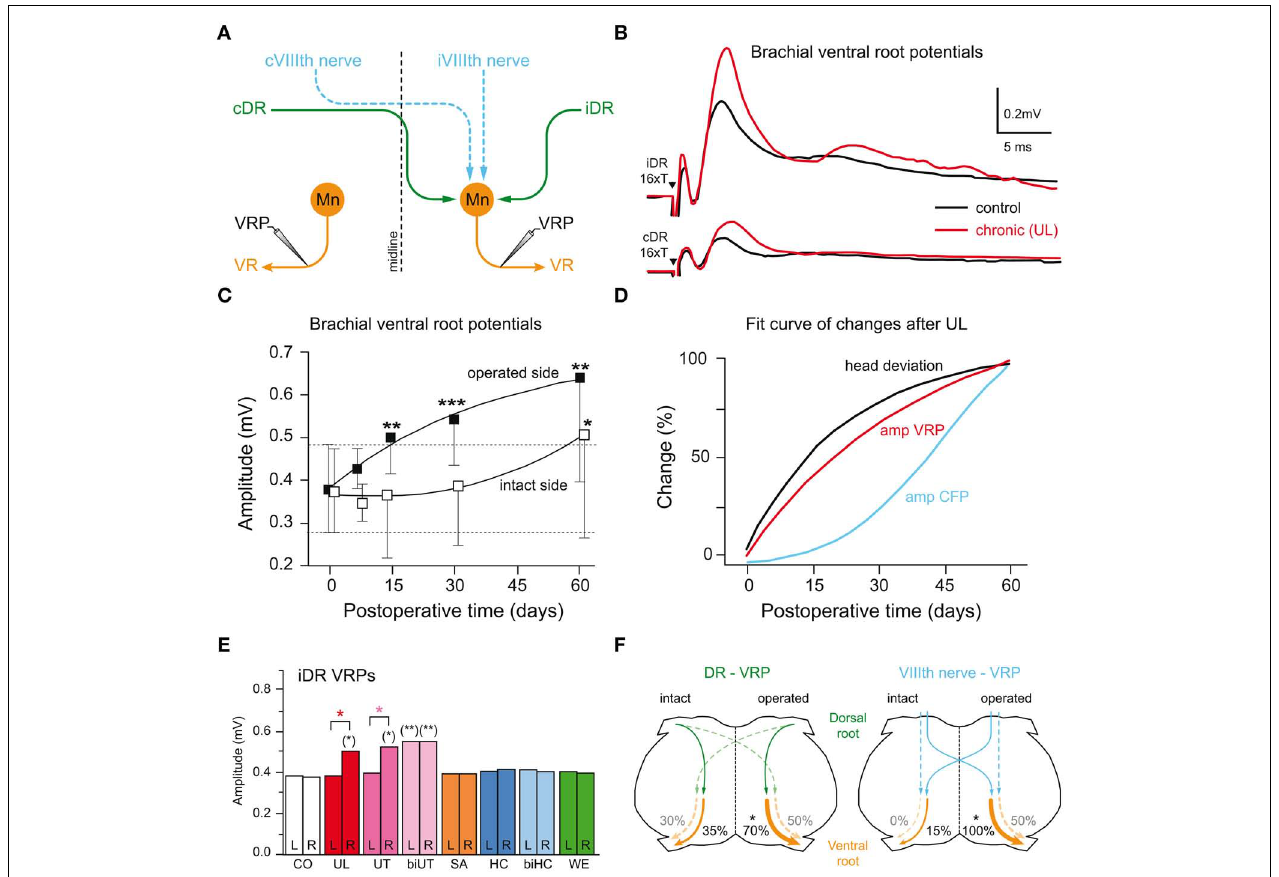
normalization of the head roll tilt (black). (E) Mean amplitudes of iDR-VRP on the left and right side in controls (CO) and in frogs 15days after different selective labyrinthine nerve lesions or with a weight mounted eccentrically on the head (WE). UT, SA, HC, unilateral utricular, saccular, horizontal canal nerve section on the right side, respectively; biUT, biHC, bilateral utricular, horizontal canal nerve section; significance of difference between the left and right side is indicated by orange asterisks and with respect to controls by asterisks in parentheses (* P ≤ 0.05; ** P ≤ 0.001). (F) Schematic drawing of a spinal cord cross-section summarizing relative changes in amplitudes with respect to controls (* P ≤ 0.05) in propriospinal (iDR/cDR-VRP; left) and vestibulo-spinal (iVIIIth/cVIIIth nerve-VRP; right) pathways after UL; data adopted from Straka et al. (1993) and Straka and Dieringer